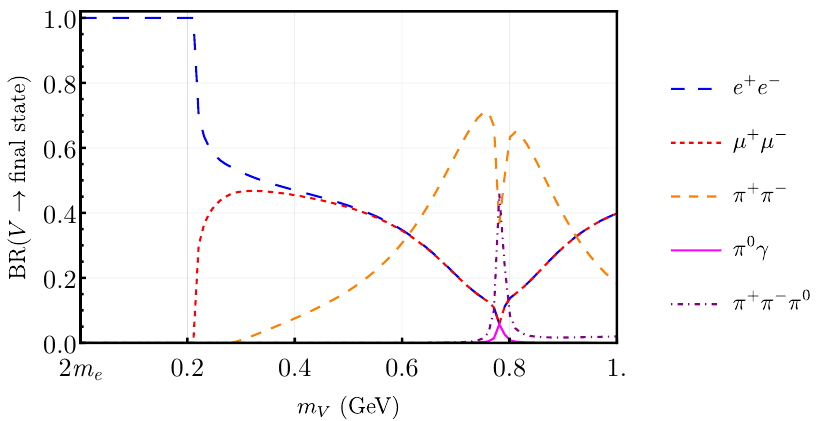
Figure 3 . Branching ratios for the dark photon decay to different final states.